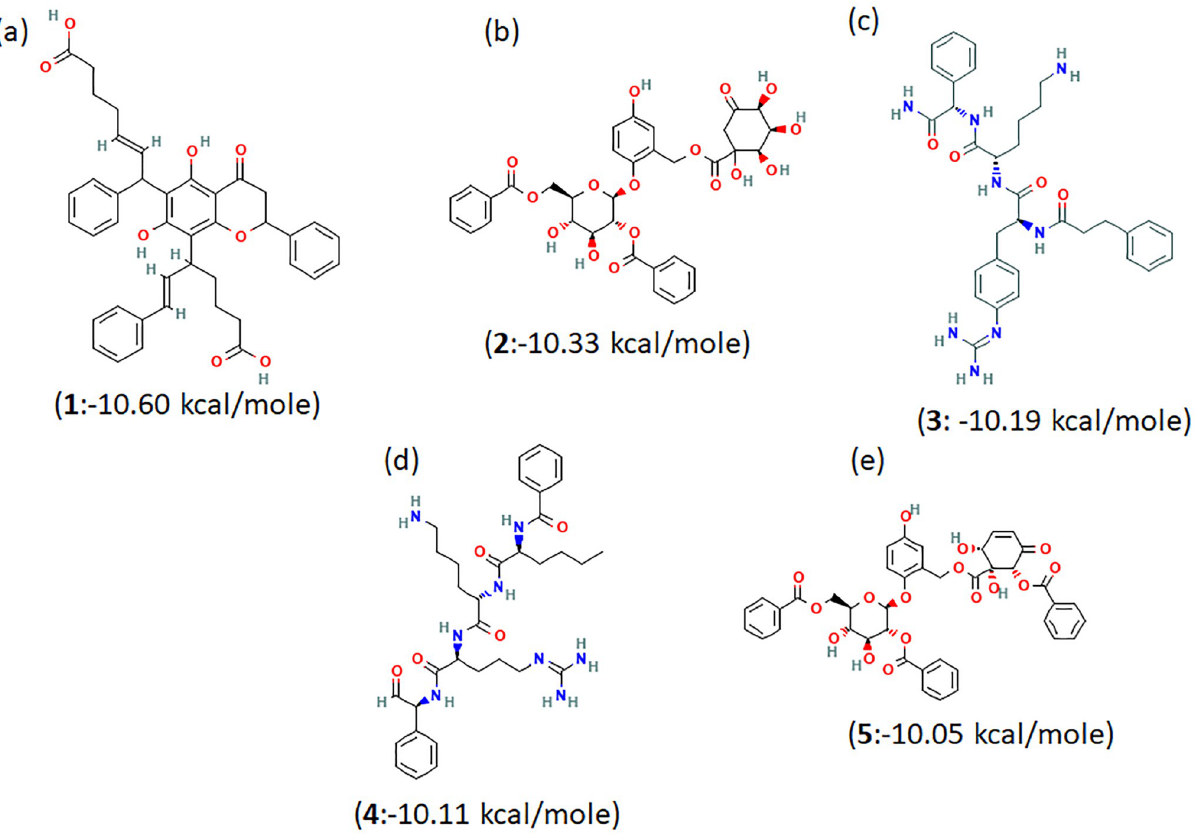
Fig 4. 2D chemical structures of top 5 compounds obtained via HTVS, SP and XP screening with their binding score. (a) CHEMBL1940602 (b) CHEMBL2036486 (c) CHEMBL3628485 (d) CHEMBL200972 and (e) CHEMBL2036488.